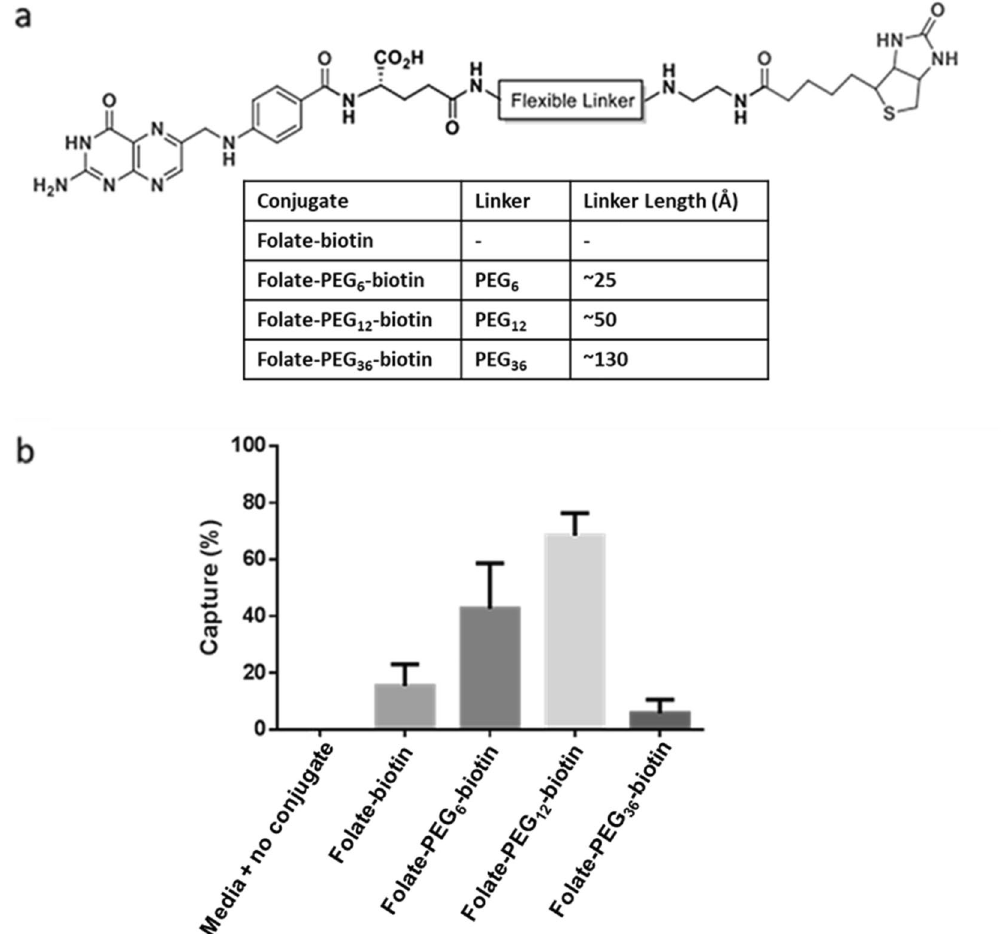
Figure 2. ( a ) Chemical structures of folate-biotin conjugates containing different PEG spacer lengths. ( b ) FR + cell capture efficiency of bispecific folate-biotin conjugate in cell culture media. For analysis of cell capture efficiency, KB cancer cells were spiked into folate-deficient RPMI medium and incubated with folate-conjugated magnetic beads for 1 h. After retrieval of the bead-coated cells with a Dynal-MPC-L magnetic particle concentrator, the captured cells were counted under a